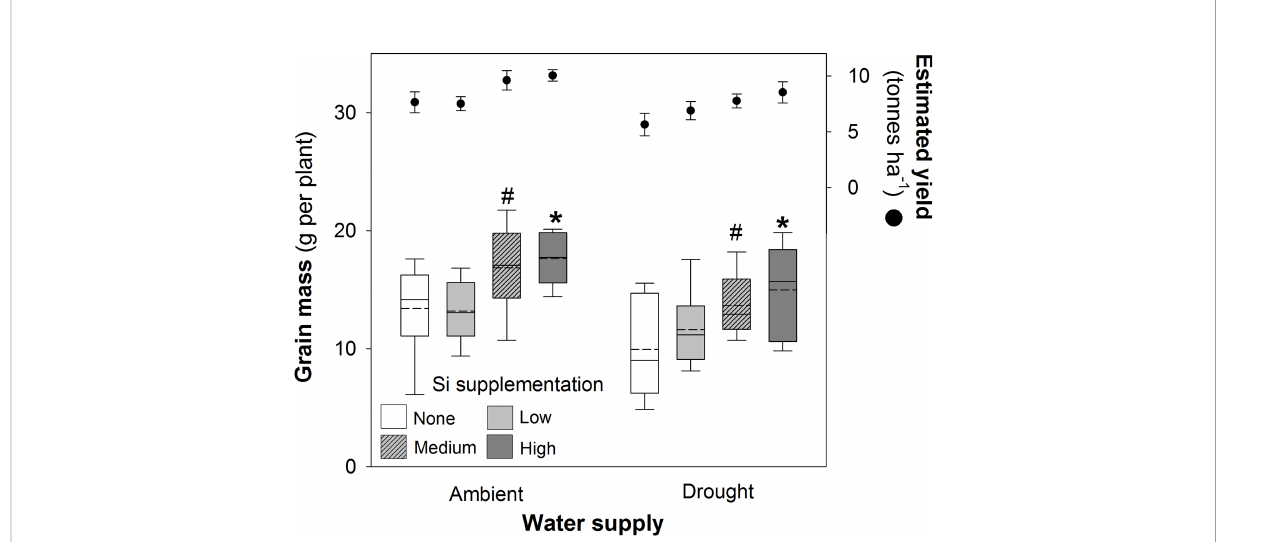
Based on the current sowing rates, we estimate an increase in grain yield from 7.7 to 10.1 tonnes ha -1 (39%) under ambient water conditions and 5.7 to 8.5 tonnes ha -1 (49%) under drought conditions (Figure 5). As discussed below, this is likely to be an